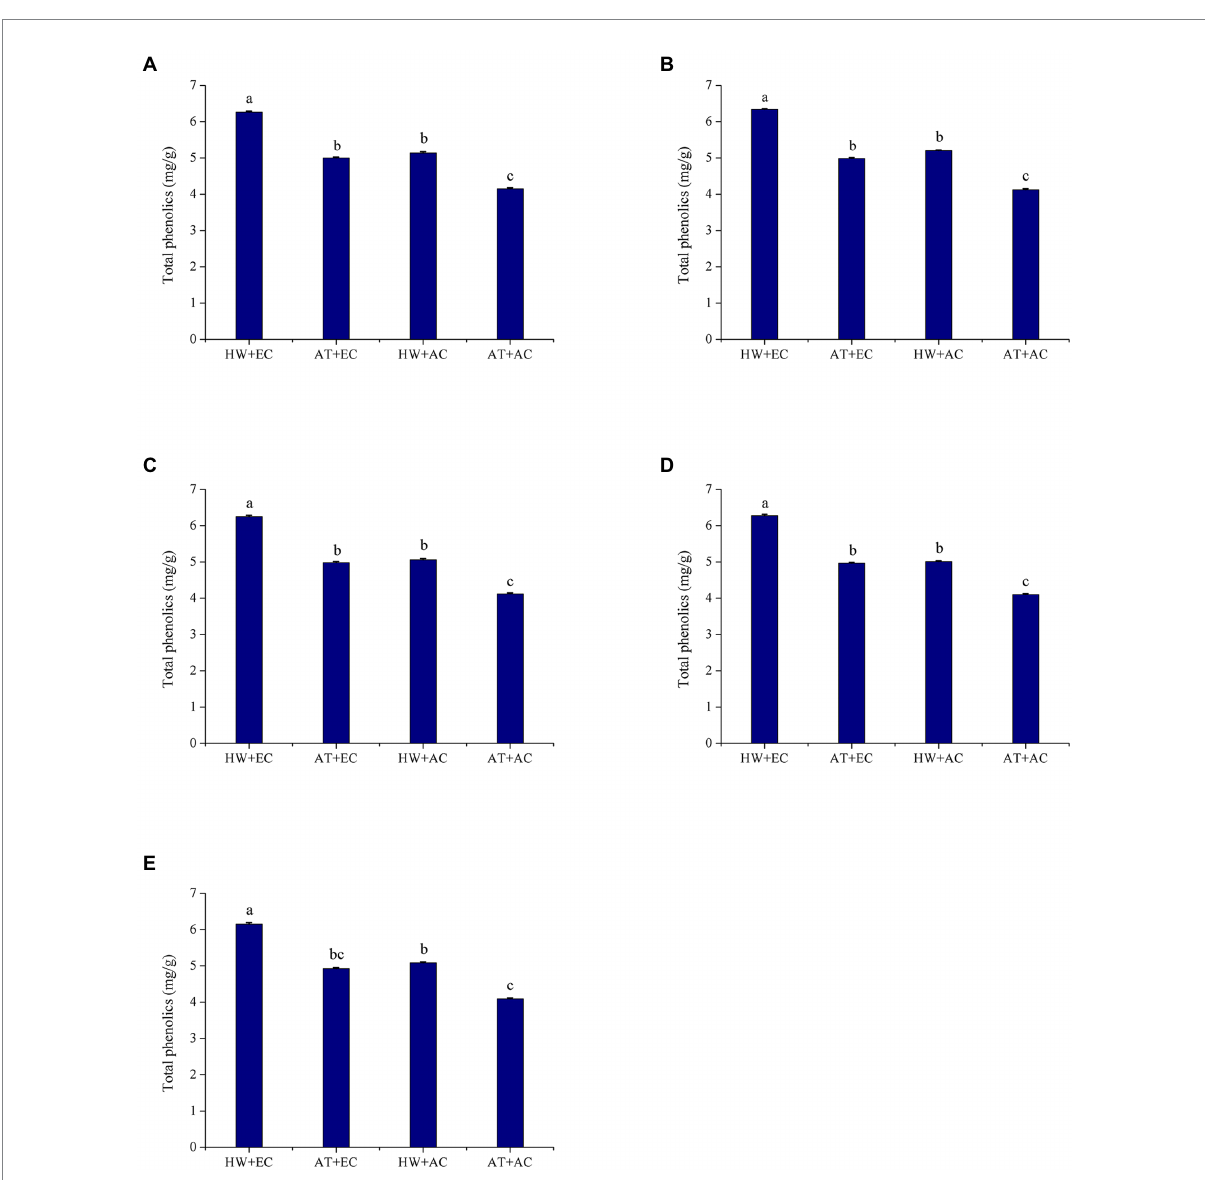
FIGURE 1 Total phenolic concentration (±SE) of Ambrosia artemisiifolia under different stress conditions ( n = 5). Data represented by columns bearing the same letters were not significantly different (LSD, p = 0.05). (A–E) Represent the first, second, third, fourth, and fifth measurements, respectively. AT denotes the ambient temperature condition; HW denotes the heat wave condition. EC and AC represent elevated atmosphere CO 2 concentration and ambient atmosphere CO 2 concentration,